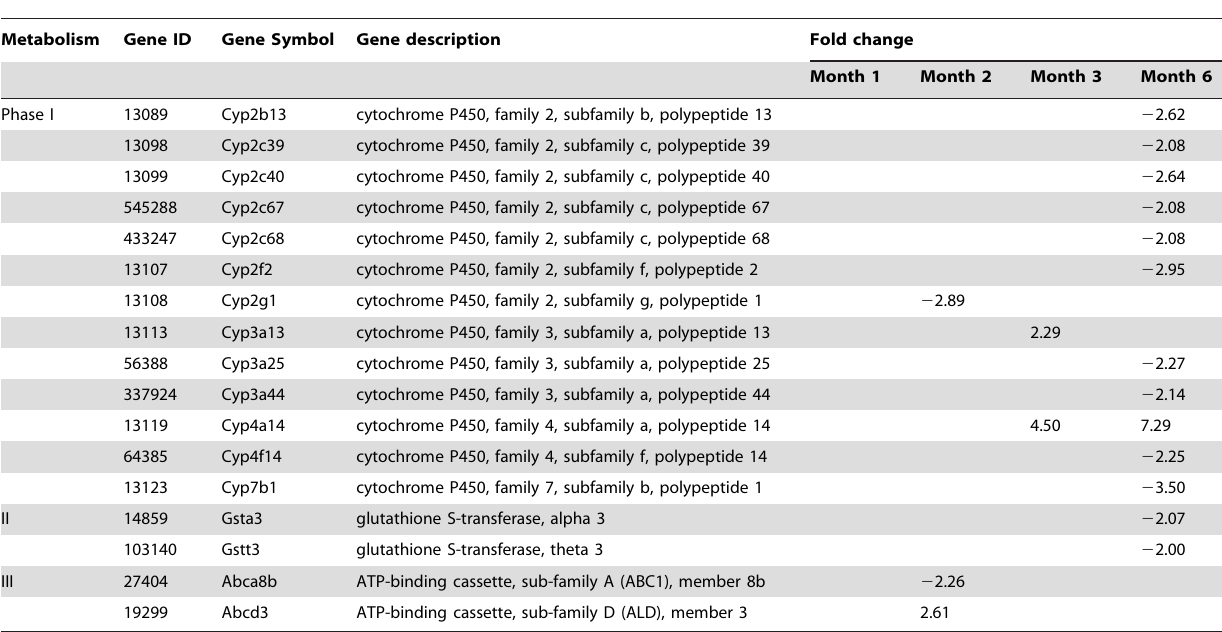
Table 5. Genes involved in drug xenobiotic metabolisms altered in the liver by E. multilocularis infection.